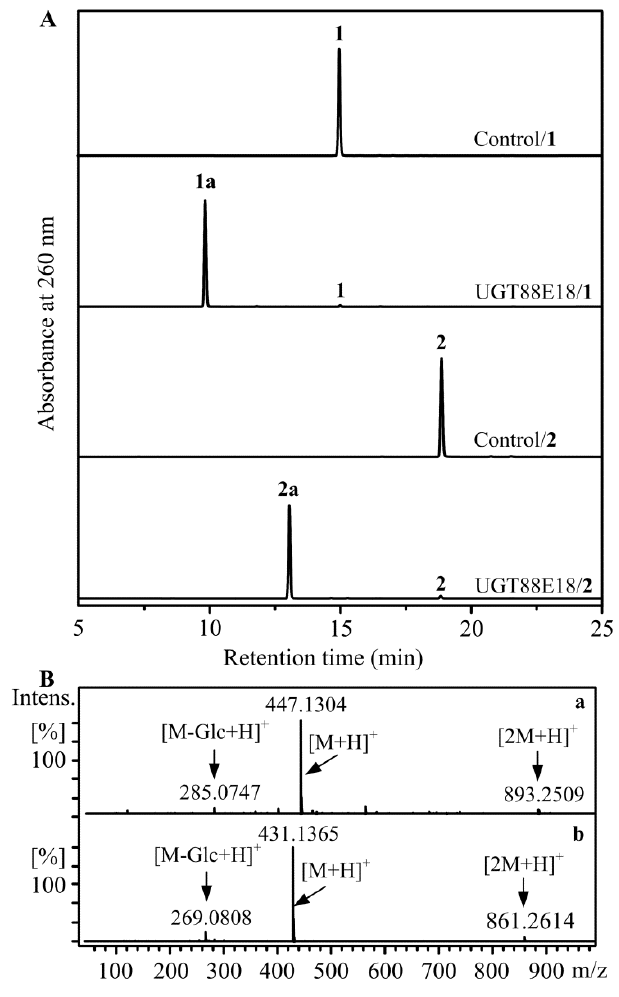
Figure 2. HPLC electrospray-ionization mass-spectrometry (HPLC-ESI-MS) analysis of glucosylated products of calycosin and formononetin. ( A ) HPLC chromatograms of calycosin, formononetin, and glucosylated products synthesized by UGT88E18. ( B ) MS spectra for Products ( a ) 1 and ( b ) 2 .